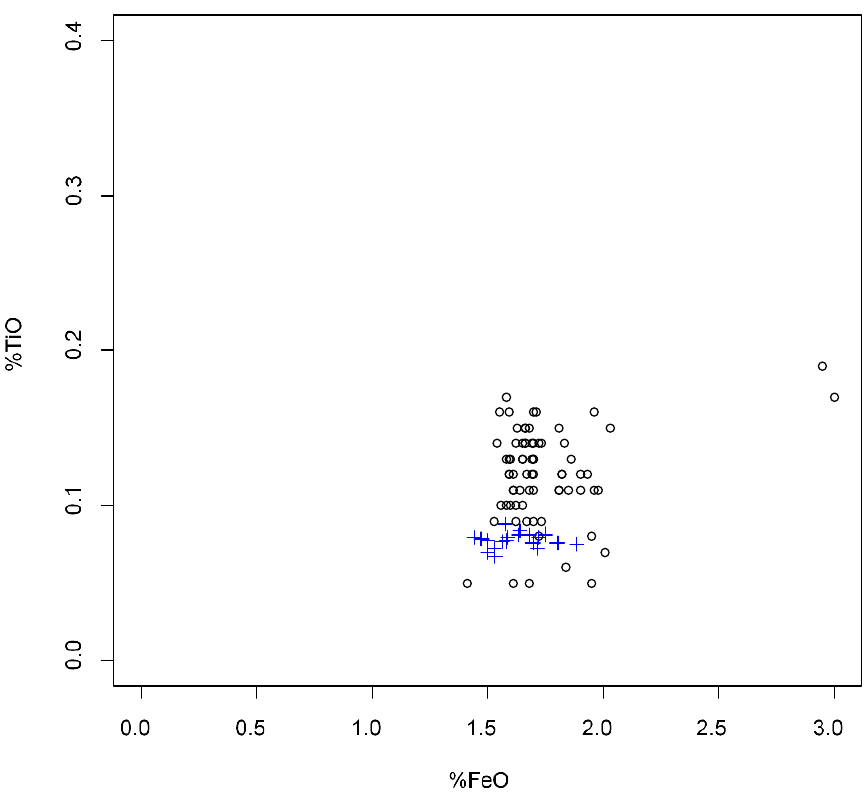
Figure A1. % TiO and FeO of reference Hekla 4 shards from Tephrabase (Newton et al . 2007), displayed as black circles, compared with shards from BADF 114.4, CATF 97.4 and BRAEO 102.4.